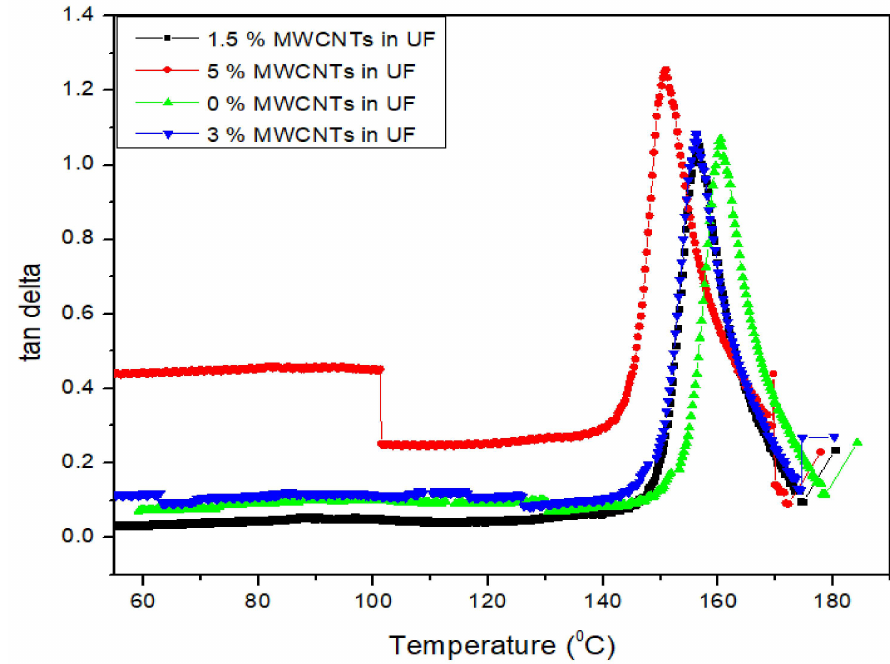
Figure 6. DMA analysis (tan delta) of UF resin with and without MWCNTs.